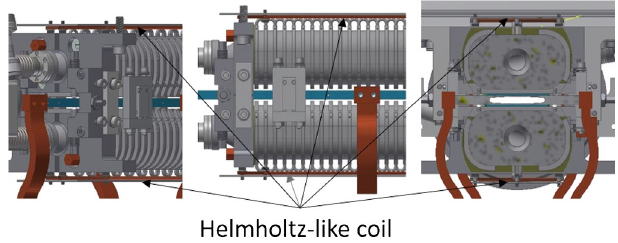
FIG. 5. Helmholtz-style coil to correct the dipole vertical field along the length of the device.